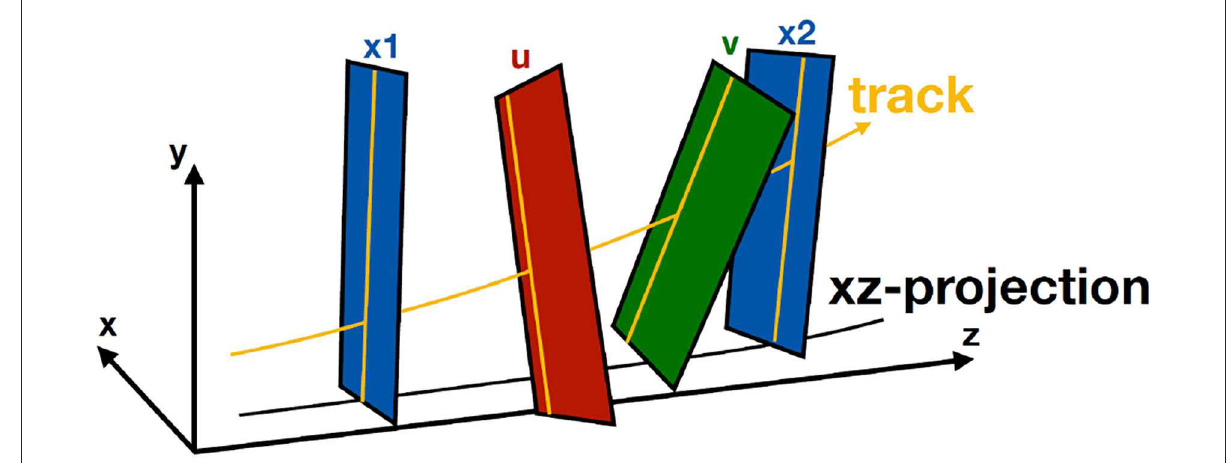
FIGURE5 Representation of a typical T-track trajectory in the SciFi. The x-z trajectory is modeled as a parabola with a fixed cubic correction, while the y-z trajectory is a line.